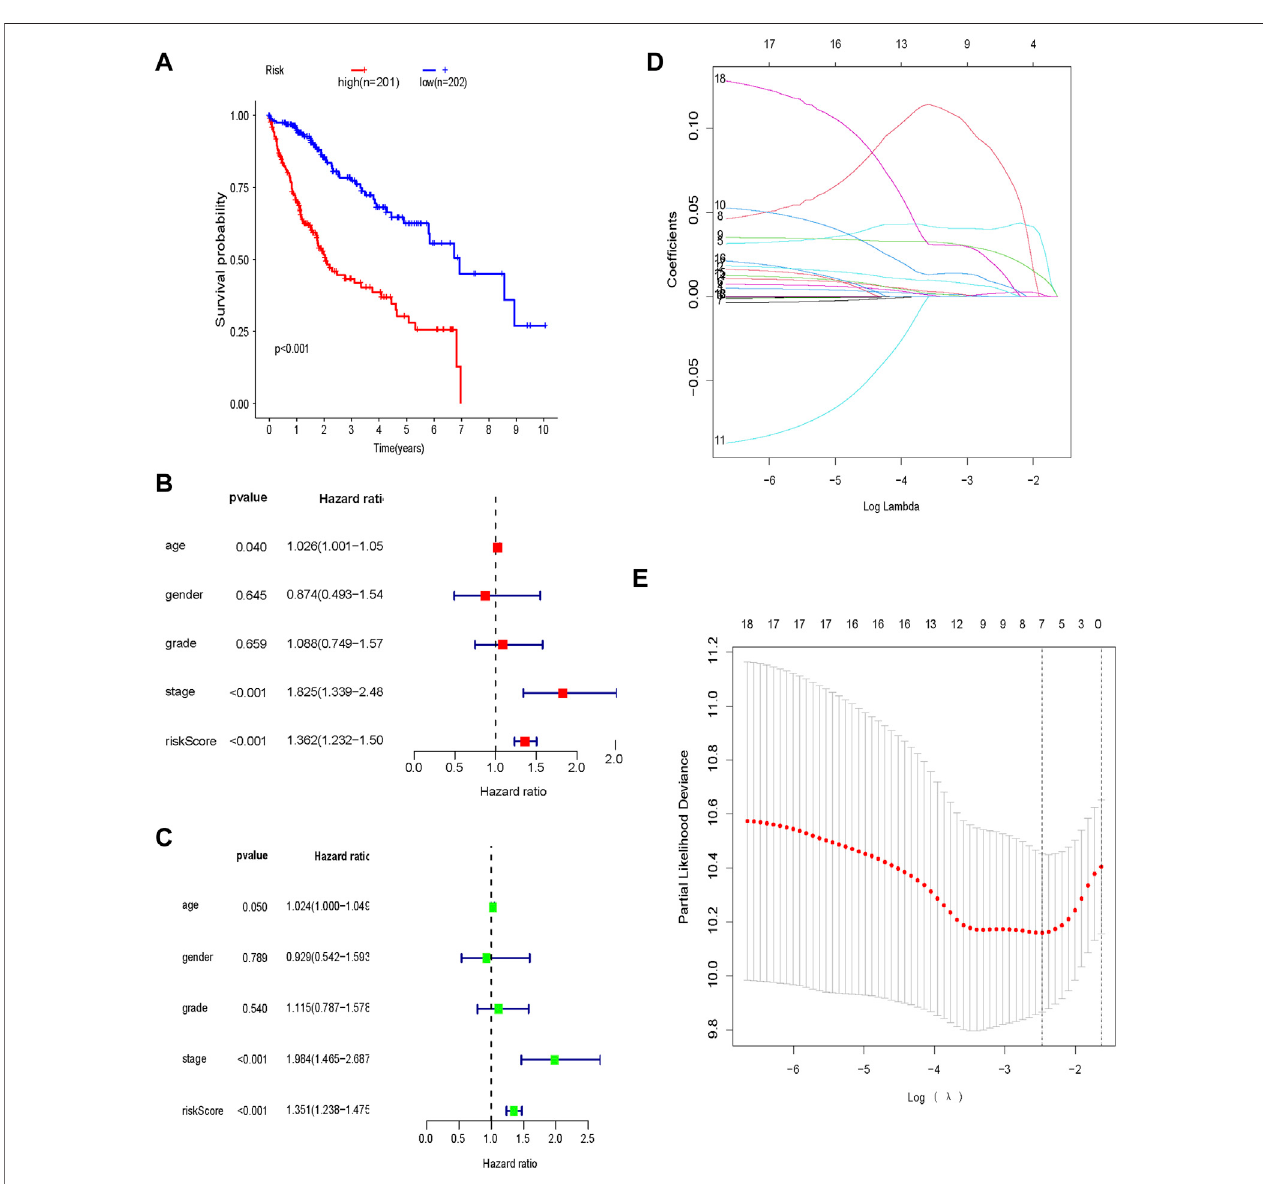
FIGURE 4 | Prognostic glycolysis-related gene signature (A) Kaplan – Meier survival analysis of the low-risk and high-risk groups; (B) Univariate Cox regression analysis of the risk score and clinical characteristics; (C) Multivariate Cox regression analysis of the risk score and clinical characteristics; (D) LASSO regression; (E) Optimal lambda